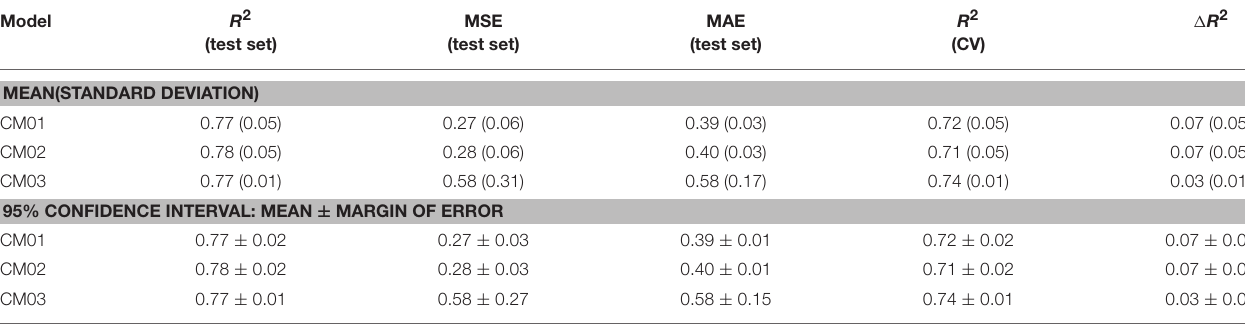
TABLE 2 | The performance of three consensus models (CM01–CM03) for the regression of relative sweetness (RS). Model R 2